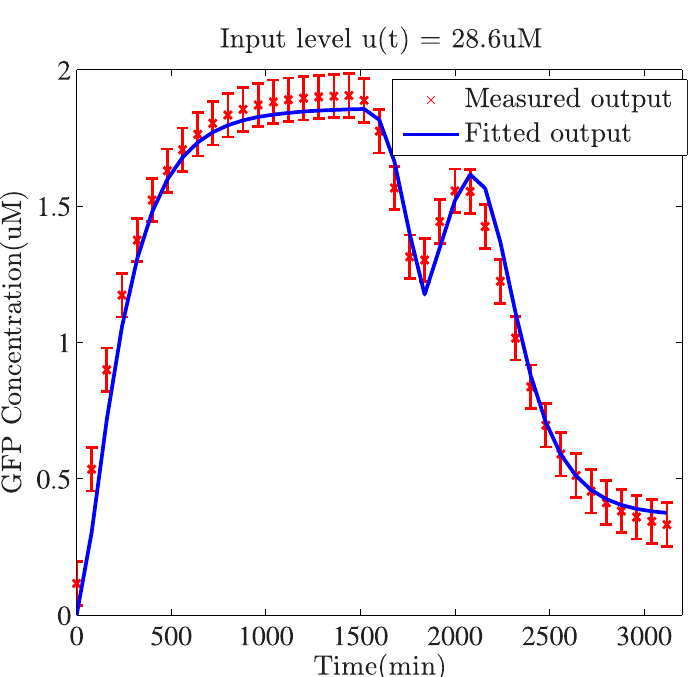
Fig 6. Curve fitting for output of buffered gene networks. In order to validate the effectiveness of estimated parameters, an additional step up signal is introduced to stimulate the response behavior of buffered systems.